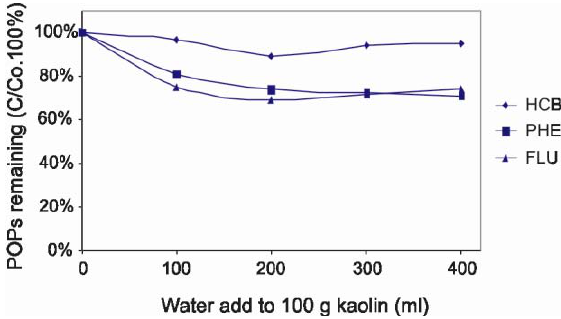
Fig. 2. POPs residual concentration (%) in kaolin at various initial moisture contents after 1 hour of ultrasound irradiation at 30 kHz and 100 W